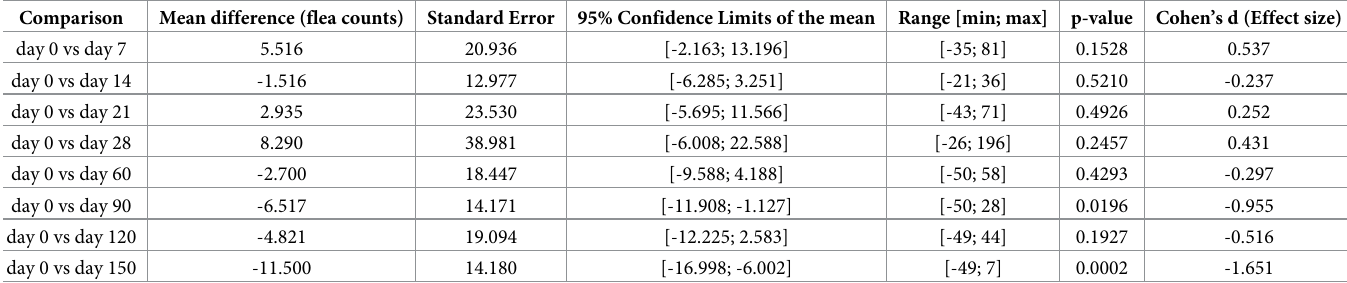
Table 5. Two-sided t-test for paired observations, estimating the difference of flea counts between day 0 and the time points after treatment for the CG.